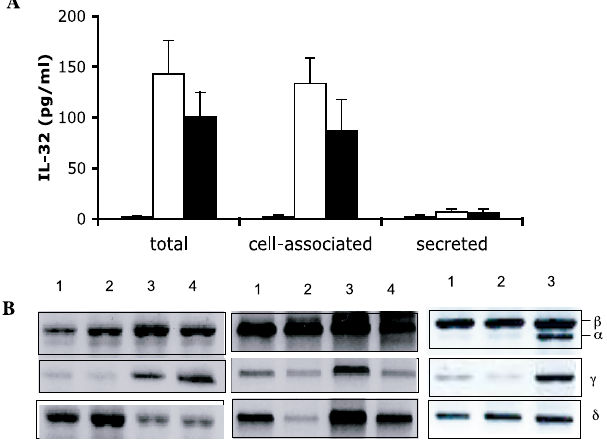
Figure 2. IL-32 Induced by Inflammatory Stimuli Is a Cell-Associated Cytokine (A) Human PBMCs were stimulated with 10 l g/ml sonicated M. tuberculosis . After 24 h, supernatants and cell lysates were assayed for IL-32 (see Methods). (B) RT-PCR of the four IL-32 isoforms in freshly lysed PBMCs (lane1), PBMCs incubated in medium for 4 h (lane 2), stimulated with 100 ng/ml LPS (lane 3), or with M. tuberculosis (lane 4). DOI: IL-32 protein in PBMC cultures after 24 h without added stimulants (Figure 3A, upper lane, and Figure 3B, left panel). However, IL-32 was present after 24 h of incubation with LPS (Figure 3A, middle lane) or M. tuberculosis (Figure 3A, lower lane). In addition, immunohistochemistry of the cytospins